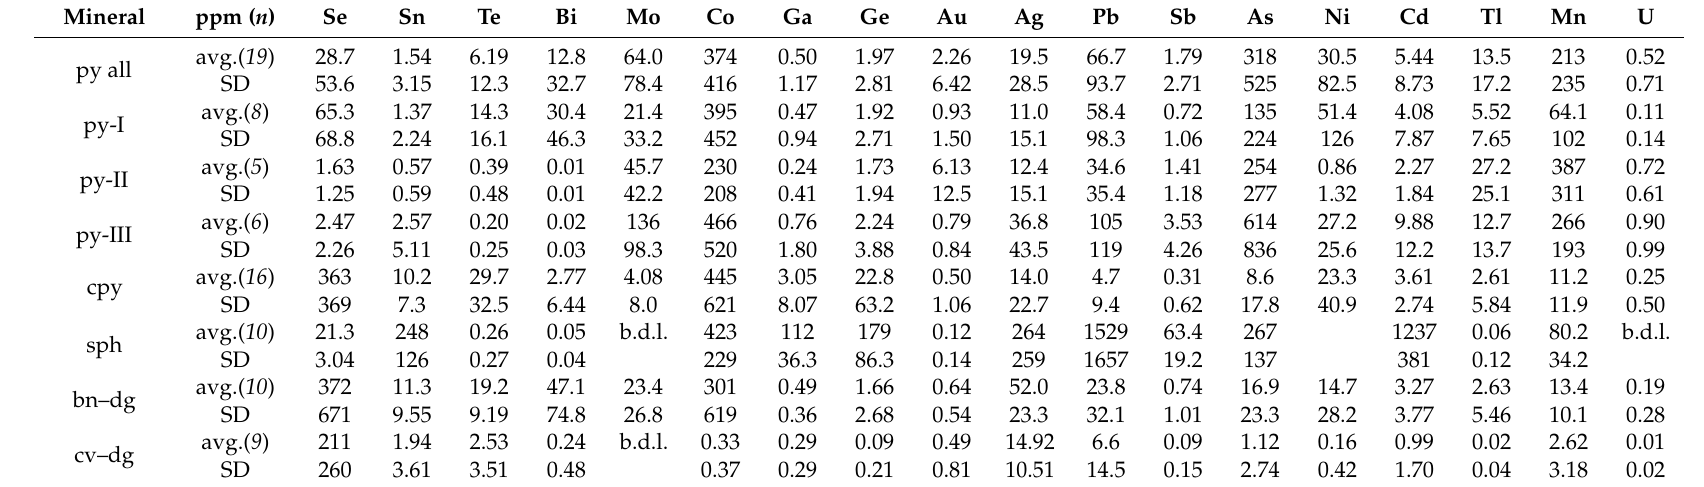
Table 2. Average trace element concentrations from LA-ICP-MS for the sulfides of the Kairei vent field.